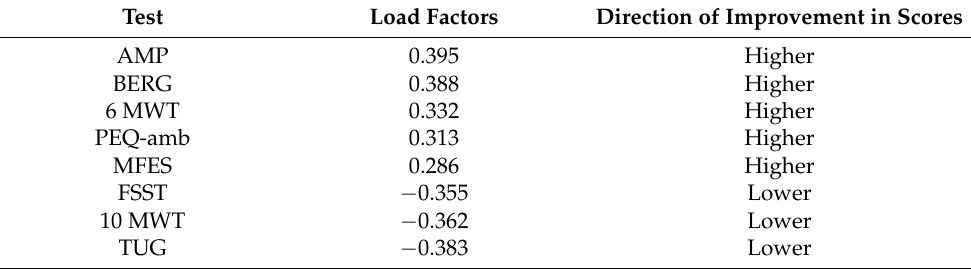
Table 3. Load factors for the first PCA component used as the X-axis in Figure